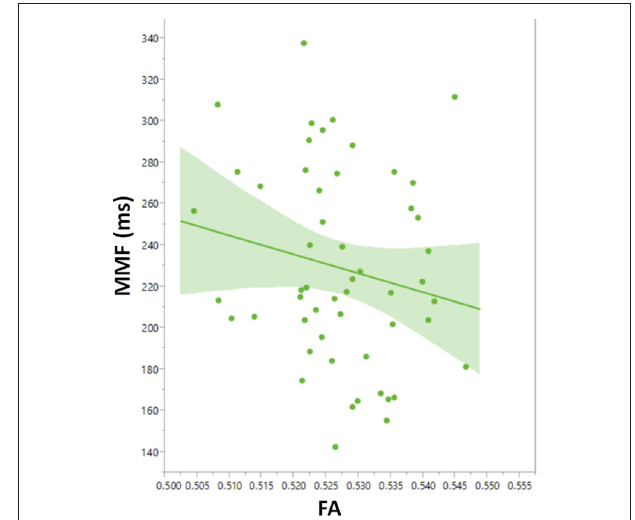
FIGURE 7 | Leverage plot of arcuate fasciculus FA vs. MMF latency in TD showing a significant correlation ( p < 0.01 ). Left and right hemisphere measures are combined in the scatter